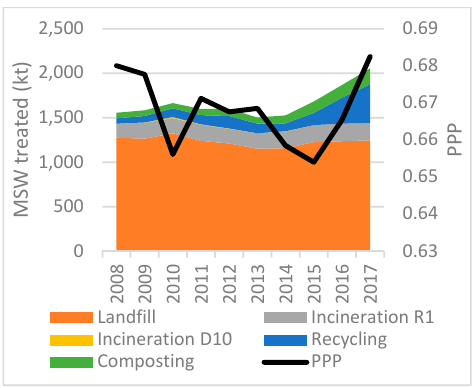
Figure 50. Waste treatment methods and PPP in Slovakia 2008–2017 (European Statistics 2019b, 2019c).